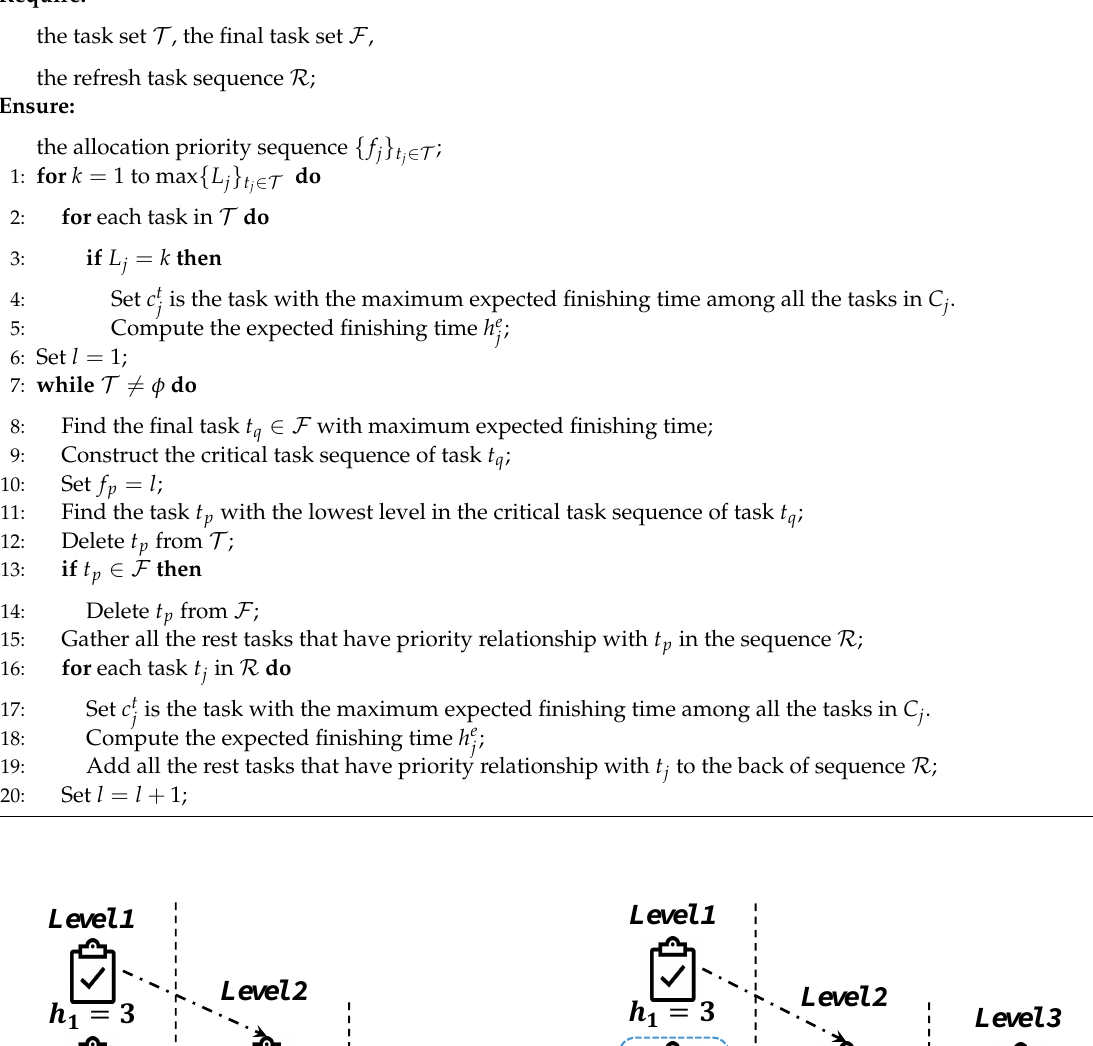
Algorithm 3 Allocation priority sequence construction